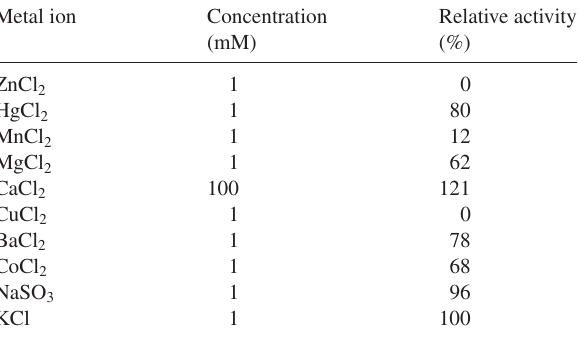
Table 2. Effects of metal ions on purified protease activity.